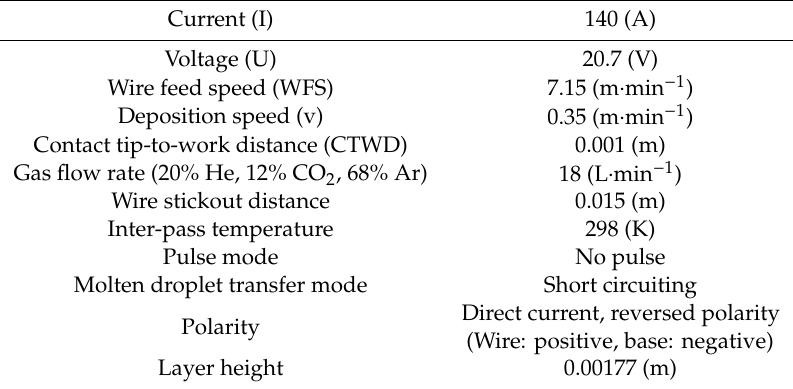
Figure 2. ( a ) Robotic wire and arc additive manufacturing (WAAM) set-up, ( b ) experimental set-up, ( c ) deposition tool path applied in this study. Table 2. Reference deposition parameters used in the study.